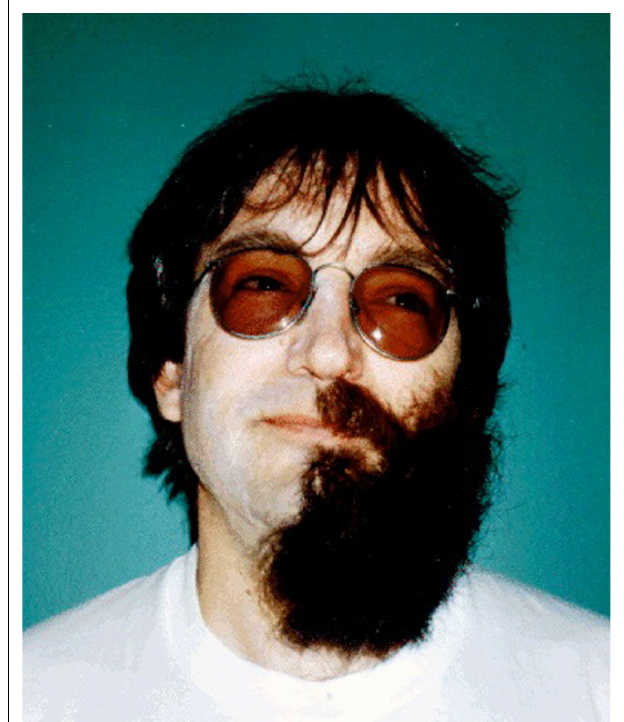
FIGURE 1 | Adult male with one half of his beard